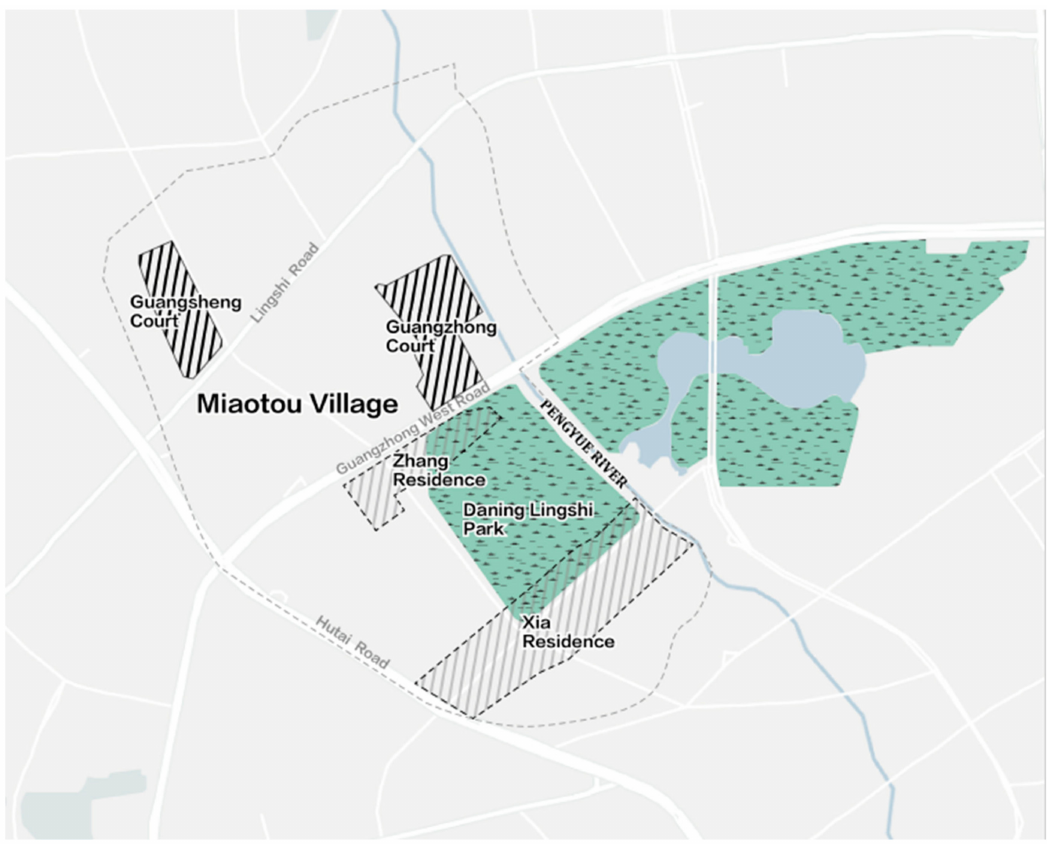
Figure 1. Miaotou Village, Past and Present. Note: Our map includes the outline of the two major residences ( zhai ) only—the ones of the Xia and the Zhang